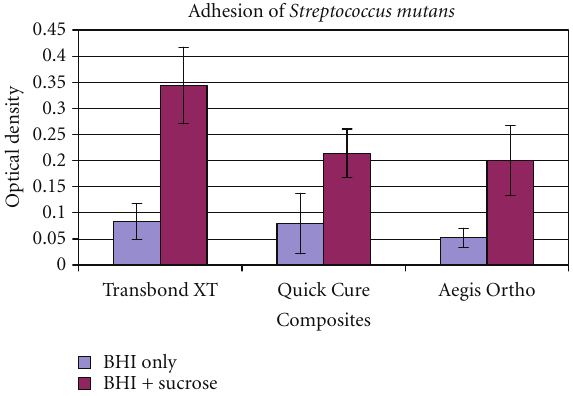
Figure 5: After 48 hours of incubation, Aegis Ortho and Quick Cure exhibited significantly less sucrose-induced S. mutans adher- ence (41.8% reduction in adherence, P = 0 . 004 and 37.7% re- duction in adherence, P = 0 . 01 resp.) than Transbond XT without ACP or fluoride (one-way ANOVA, Sche ff ´e test P < 0 .